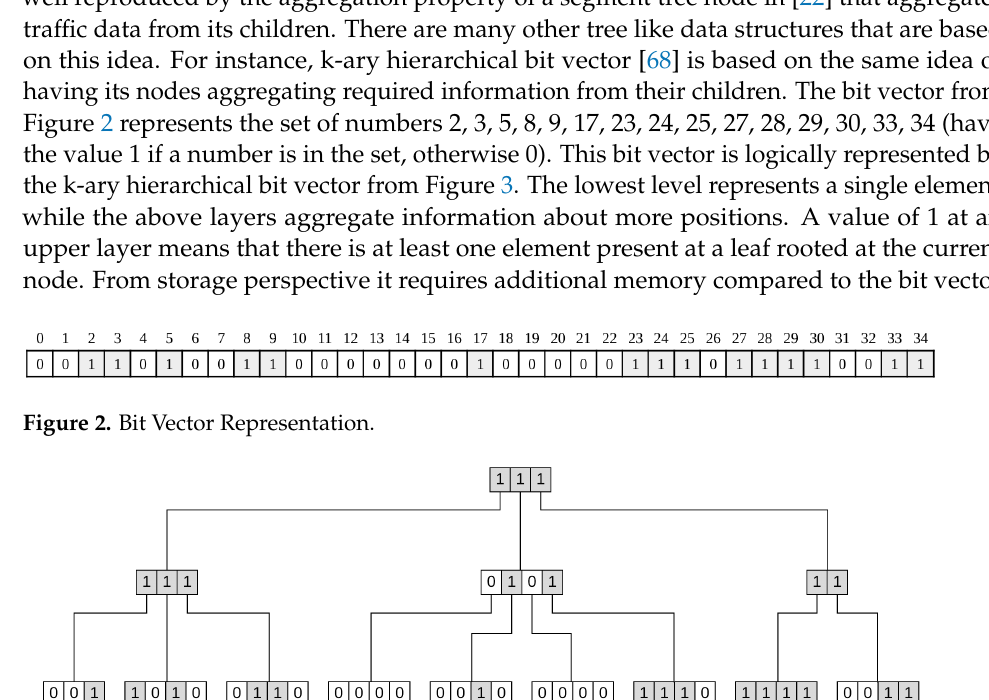
Figure 3. K-ary Hierarchical Bit Vector Representing 2, 3, 5, 8, 9, 17, 23, 24, 25, 27, 28, 29, 30, 33,